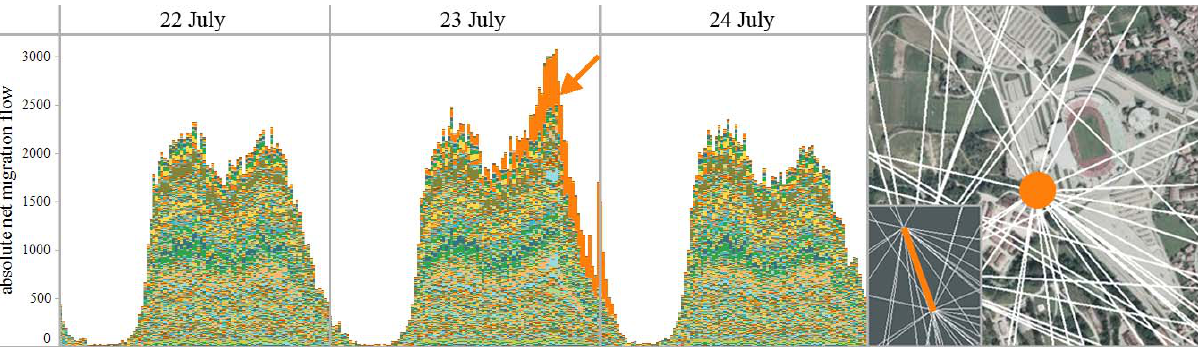
Figure 8. Bruce Springsteen Concert in Stadio Friuli, Udine, on Thursday, 23 July 2009; the outstanding orange pattern refers to the Stadium’s location as shown in the aerial photo to the right (the white lines indicate other